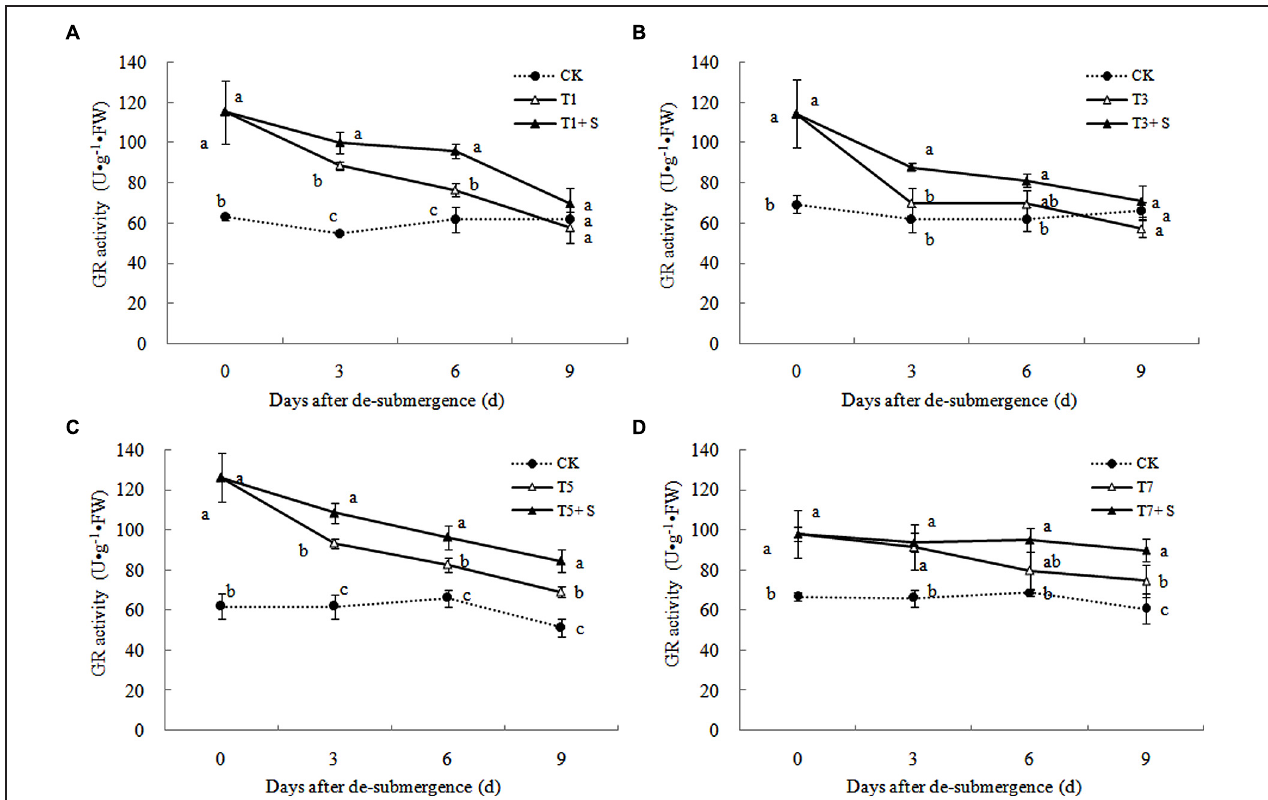
FIGURE 12 | Effects of Spd on GR activity of rice after